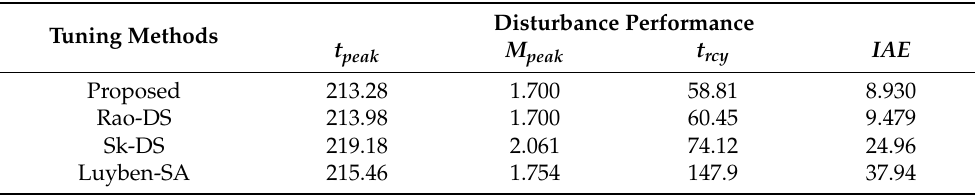
Table 5. Quantitative comparison of responses to disturbance in PIPTD with +10% parameter mismatch.